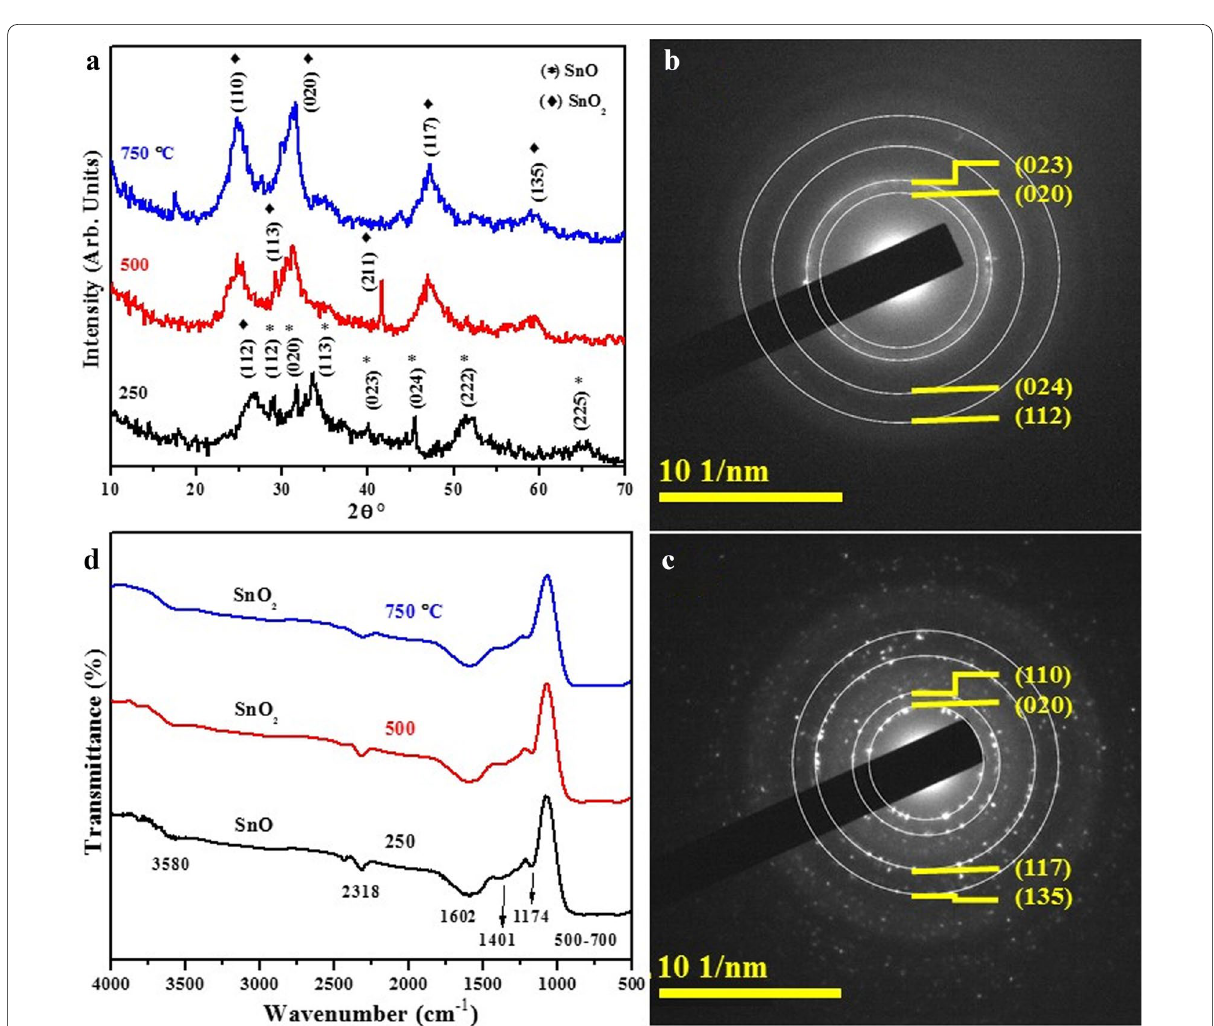
Fig. 5 a XRD spectra obtained from SnO annealed at 250, 500 and 750 °C b , c SAED rings of 250 and 750 °C samples, respectively, and d FTIR Fig. 5b, c, respectively. The analyzed patterns with lat- tice planes (020), (023), (024) and (112) are assigned to orthorhombic SnO (Fig. 5b) and (020), (110), (117) and